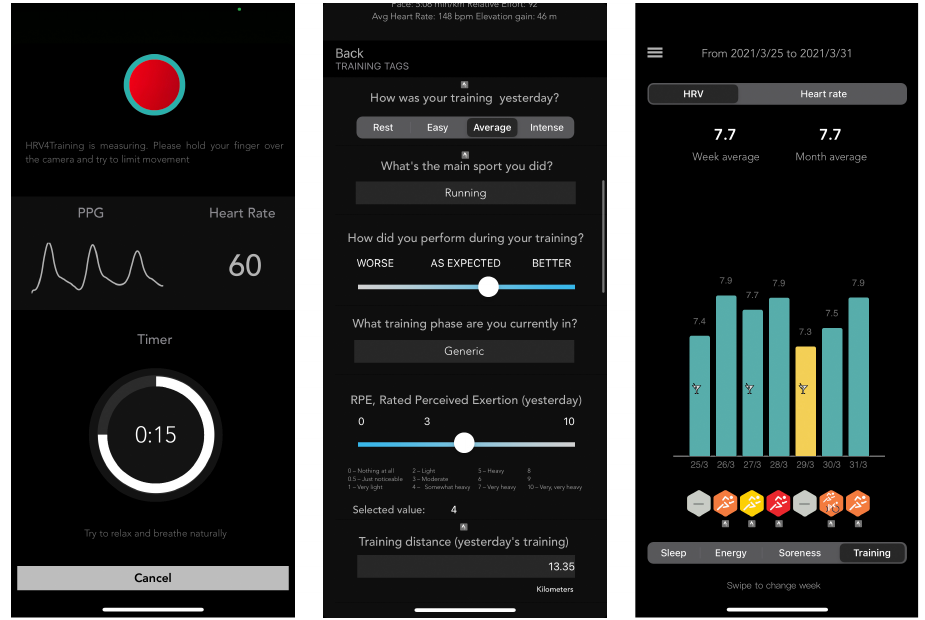
Figure 1. Screenshots of the HRV4Training app. The image on the left side shows the measurement screen, displaying the photoplethysmographic signal acquired via the mobile phone camera. The middle image shows an example of the questionnaire that is used after the measurement to annotate stressors such as training intensity, alcohol intake, sickness, or the menstrual cycle. The third image, on the right, shows a historical view of the